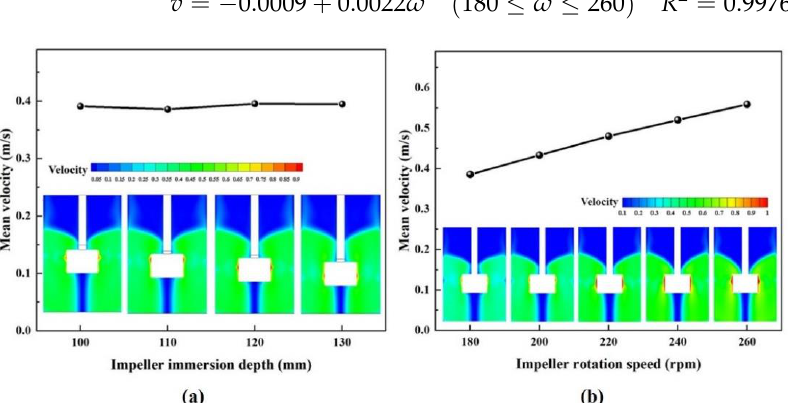
Figure 10. Comparison of the mean velocities of the fluid in the bath at different ( a ) impeller immersion depths (IIDs) and ( b ) IRSs.